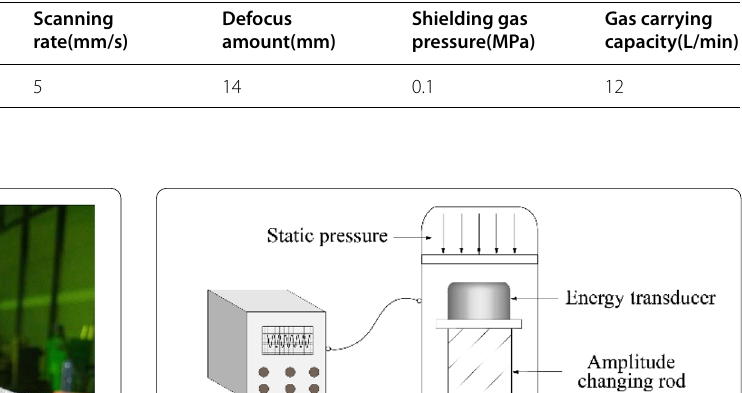
Table 5 Laser cladding parameters